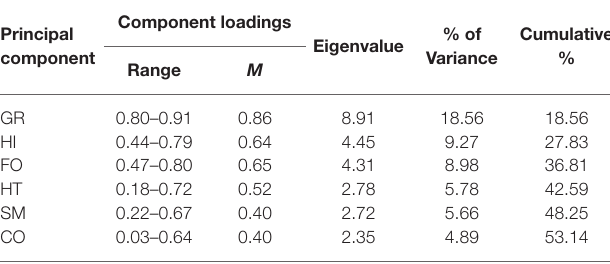
Component loadings